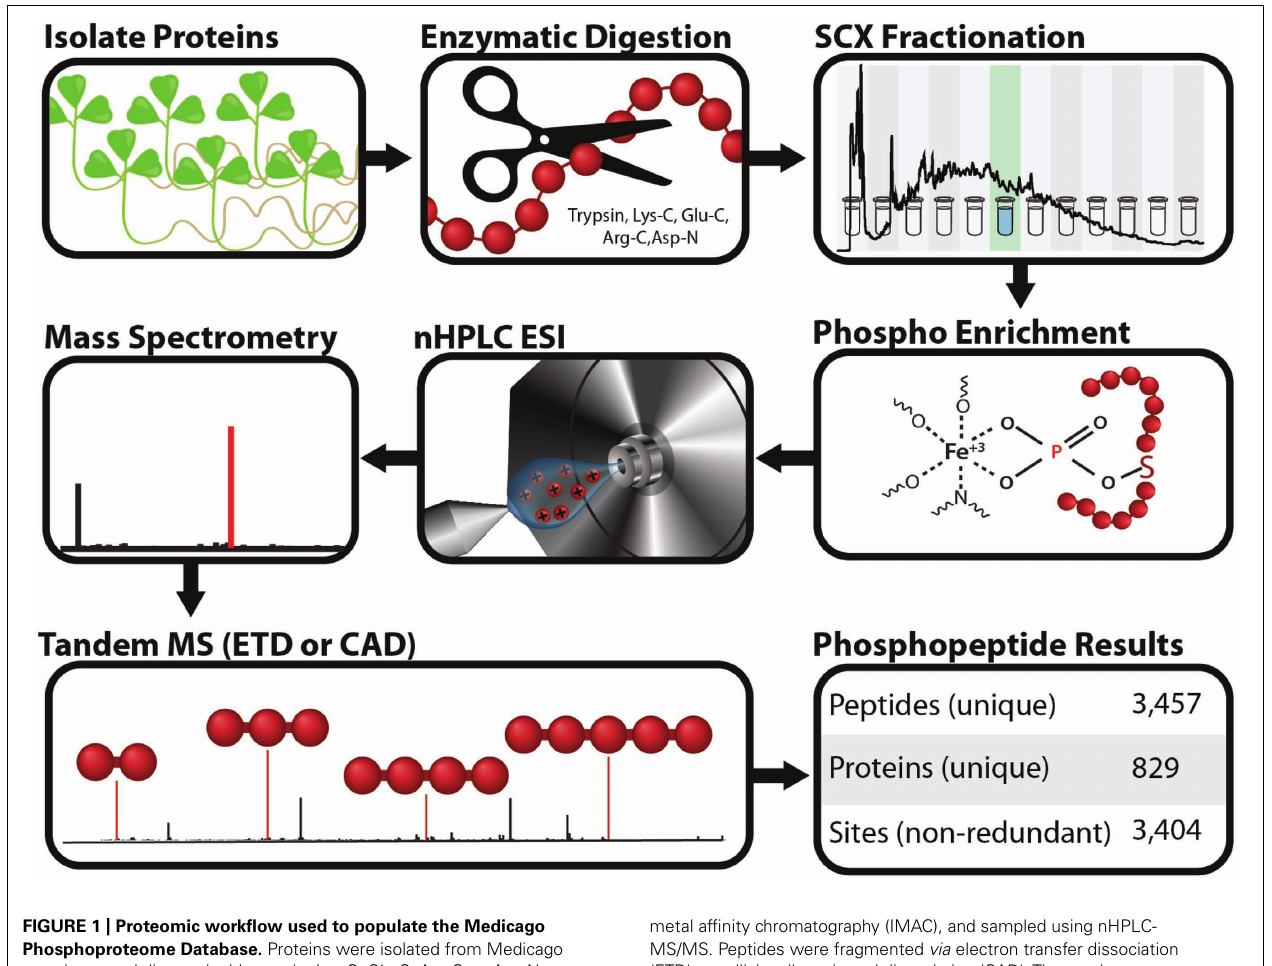
FIGURE 1 | Proteomic workflow used to populate the Medicago Phosphoproteome Database. Proteins were isolated from Medicago root tissue and digested with trypsin, Lys-C, Glu-C, Arg-C, or Asp-N to create peptides.These peptides were then fractionated by strong cation exchange (SCX), enriched for phosphopeptides by immobilized